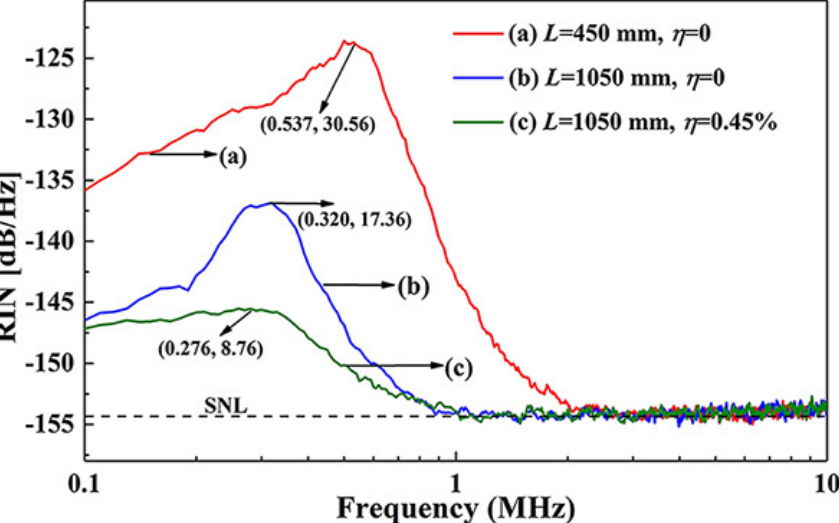
Figure 26. ( a ) Measured intensity noise spectra for L 1 laser with η = 0, ( b ) L 2 laser with η = 0, and ( c ) L 2 laser with η = 0.45% [35]. Reprinted with permission from [35] c (cid:13) The Optical